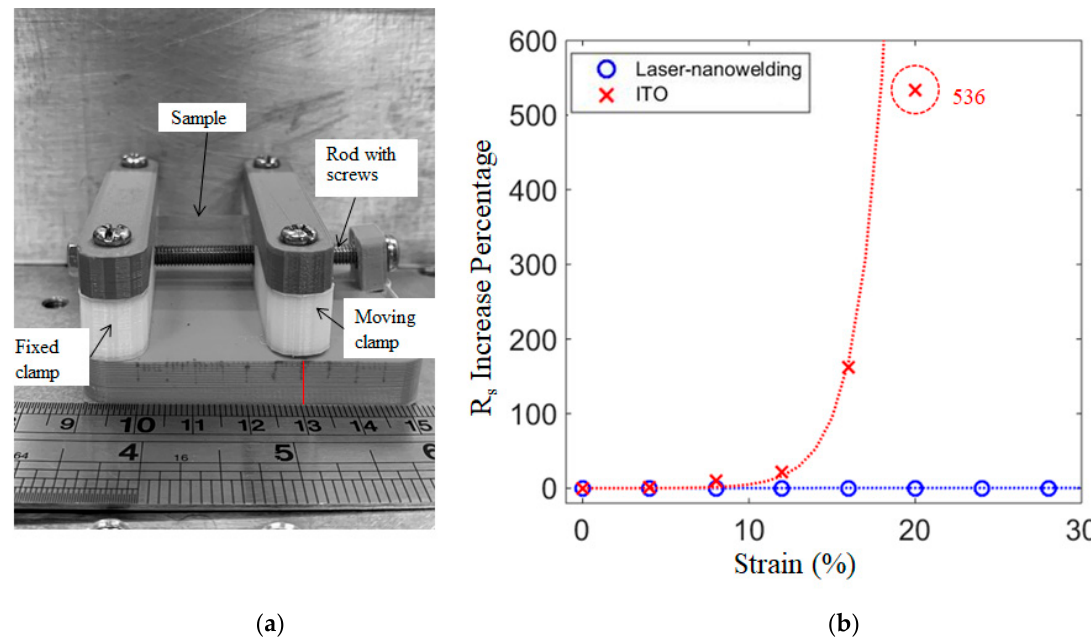
Figure 9. Stain tests of AgNWs on PET films. ( a ) Stain test device; ( b ) Sheet resistance change in stretching tests.particles with different surface functional groups as a function of medium conductivity. ( b ) The case for 3- µ m